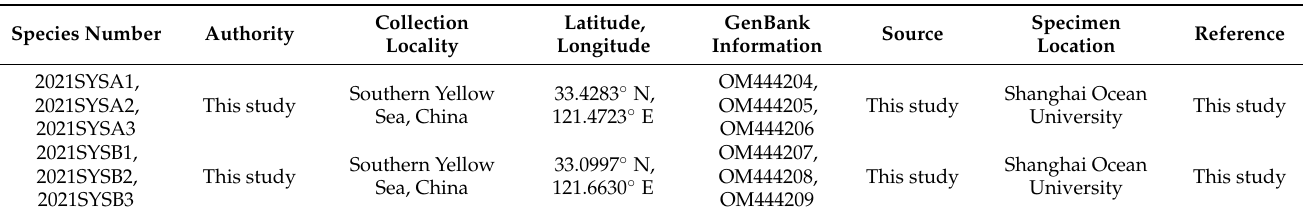
Table 1. Detailed information about the macroalgae used to build the phylogenetic